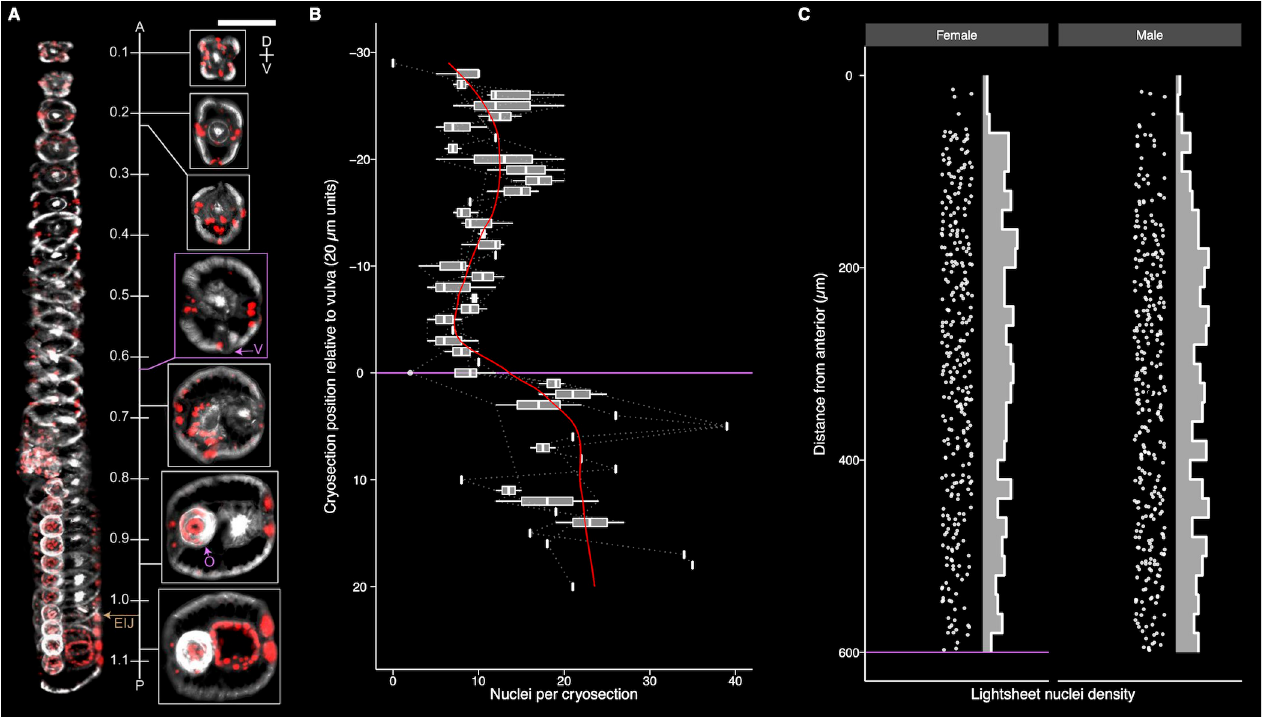
Fig 3. Optimization of spatial cryo-embedding and nuclei distribution in adult B . malayi . (A) The integrity and position of tissues is not impacted by cryopreservation and is accurately captured for RNA tomography. 3D rendered (left) and representative (right) views of 20 μ m cryosections covering the anterior most portion of the adult female head highlighting the vulva = purple V, uterus = purple U, and esophageal-intestinal junction = brown EIJ. DAPI = red, phalloidin = grey, A = anterior, P = posterior, D = dorsal, V = ventral, scale bar = 100 μ m, numbers are mm from anterior. (B) Adult female nuclei counts per 20 μ m cryosection relative to the vulva and start of the reproductive tract (purple line). (C) Adult male and female DRAQ5 stained nuclei density, captured anterior to the vulva (purple line) with light sheet imaging.